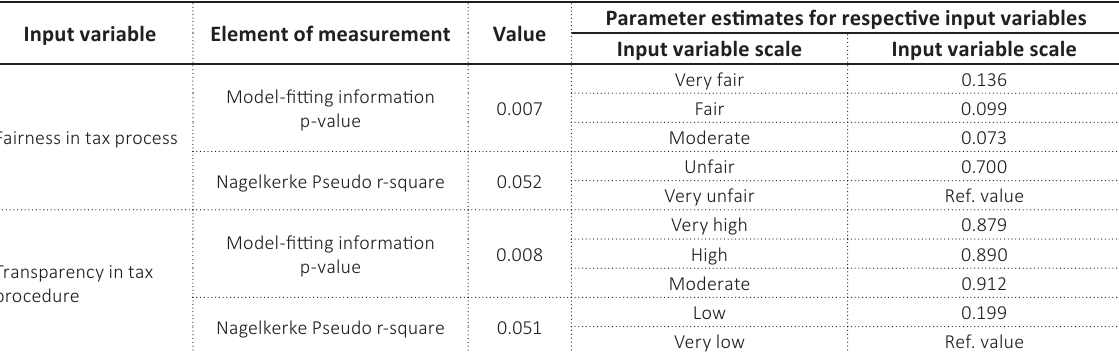
Table 11. Ordinal regression analysis between different variables and the level of tax